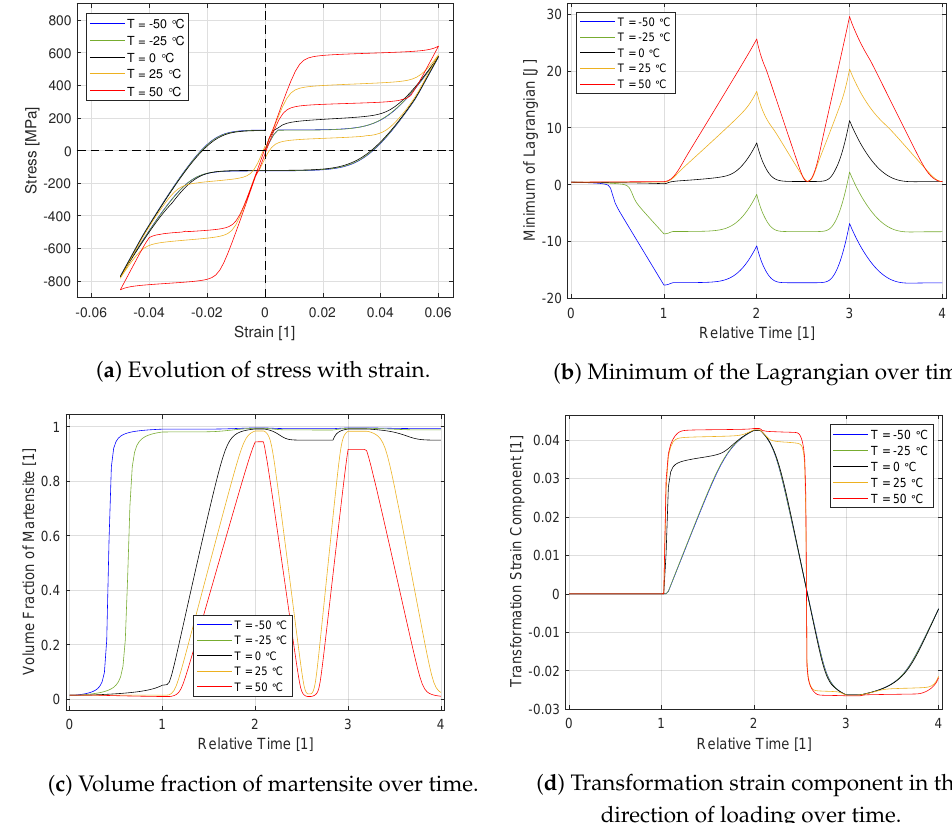
Figure 2. Uniaxial tests at five different temperatures (Example